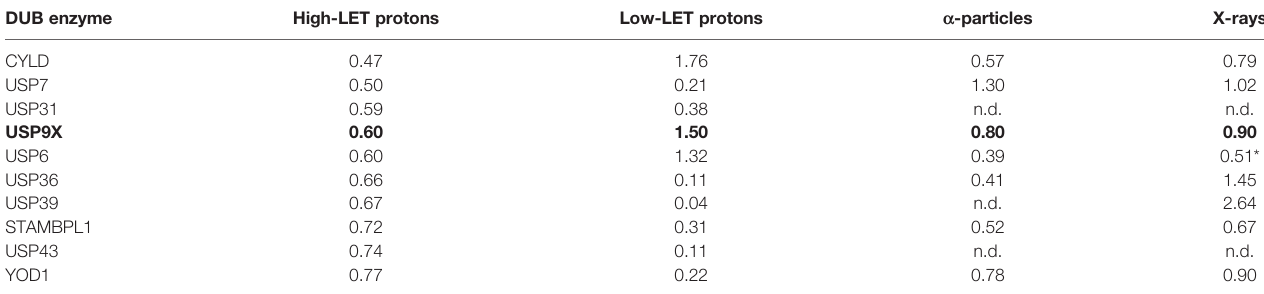
TABLE 2 | Candidate DUBs whose siRNA-mediated depletion enhance radiosensitivity of cells in response to high-LET protons. DUB enzyme